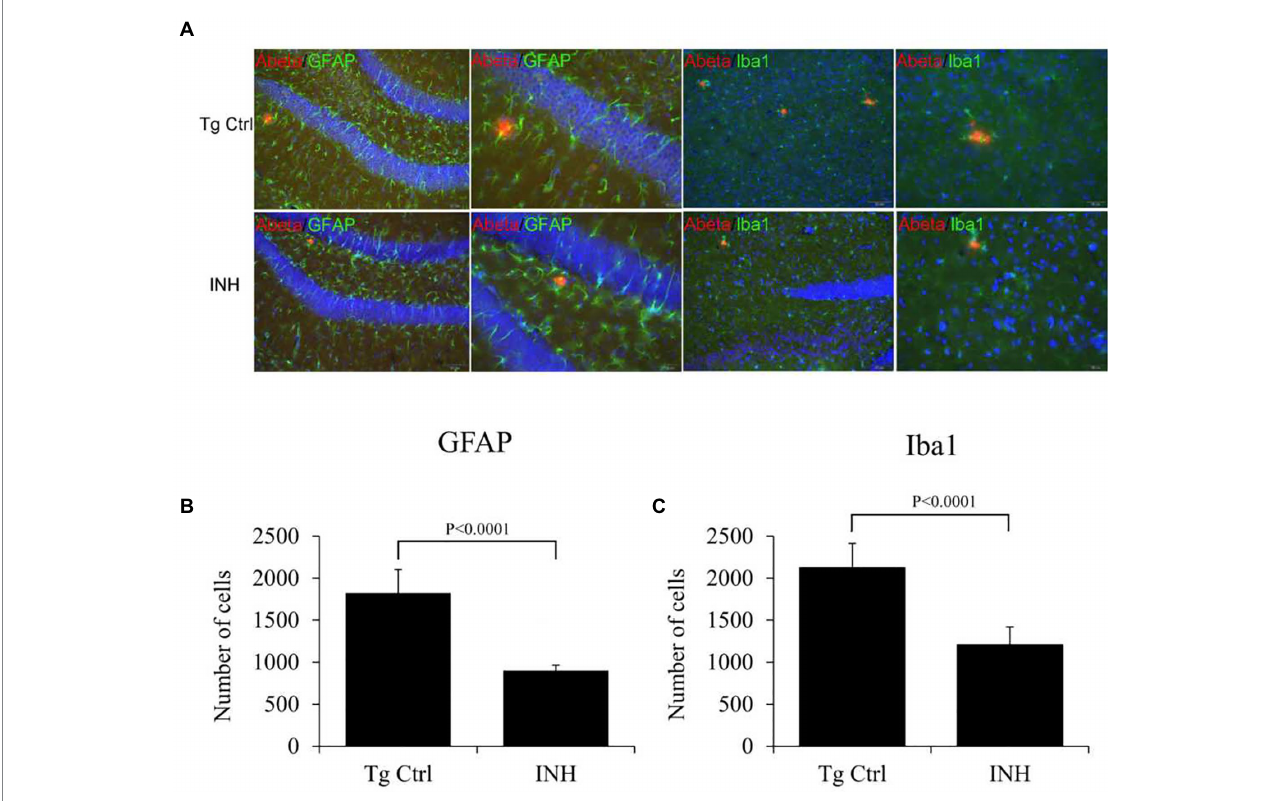
FIGURE 6 (A–C) INH reduced the microglial and astrocytes activation. Representative confocal images showed the A β plaques (red), microglial cells (IBa1+ cells, green), and activated astrocytes (GFAP+ cells, green) in the subgranular zone of the hippocampus of the INH group and the Tg Ctrl group. The numbers of microglia or activated astrocytes around the A β plaques were quantitated. ** p < 0.01, compared with the Tg Ctrl